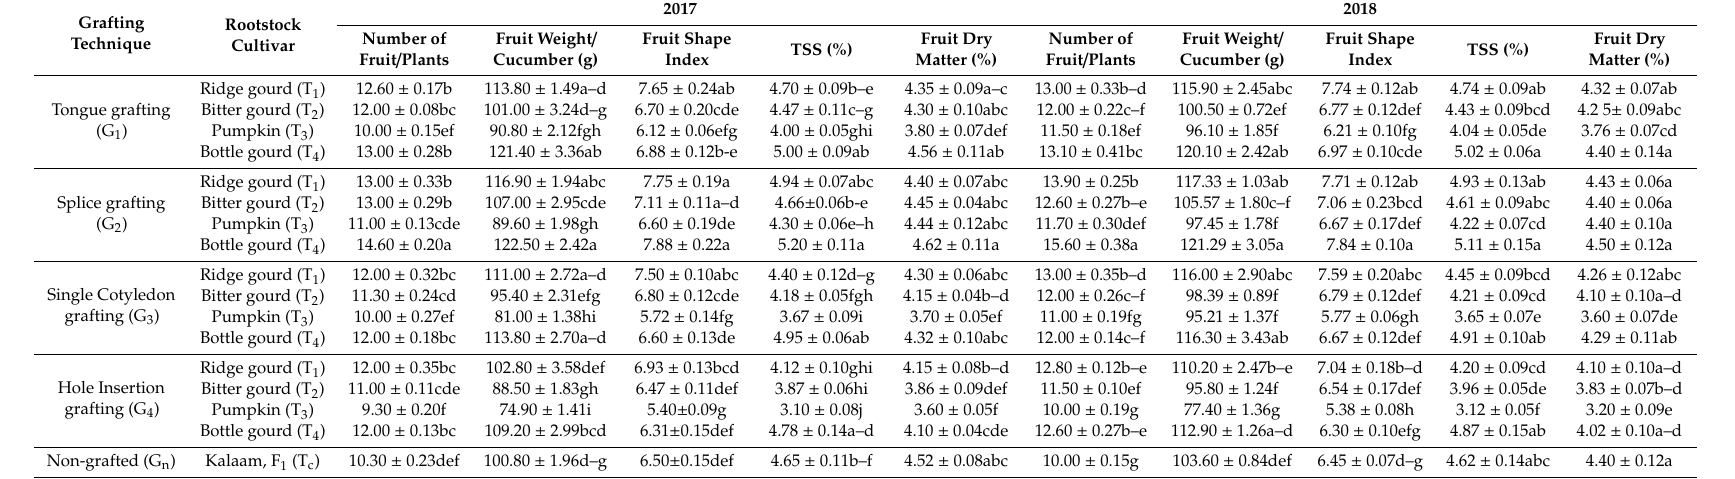
Table 4. E ff ect of Scion / rootstocks combinations (grafting) on cucumber fruit growth and yield. TSS: Total soluble